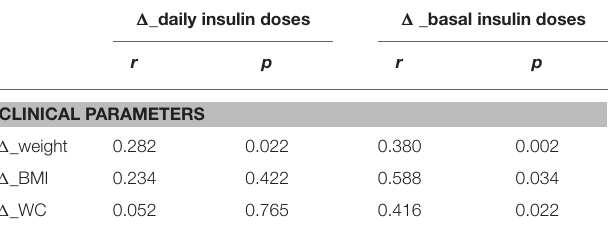
TABLE 3 | Bivariate correlations between 1 _weight, 1 _BMI and 1 _WC with 1 _daily insulin doses (U/day) and 1 _basal insulin doses (U/day) in patients of group